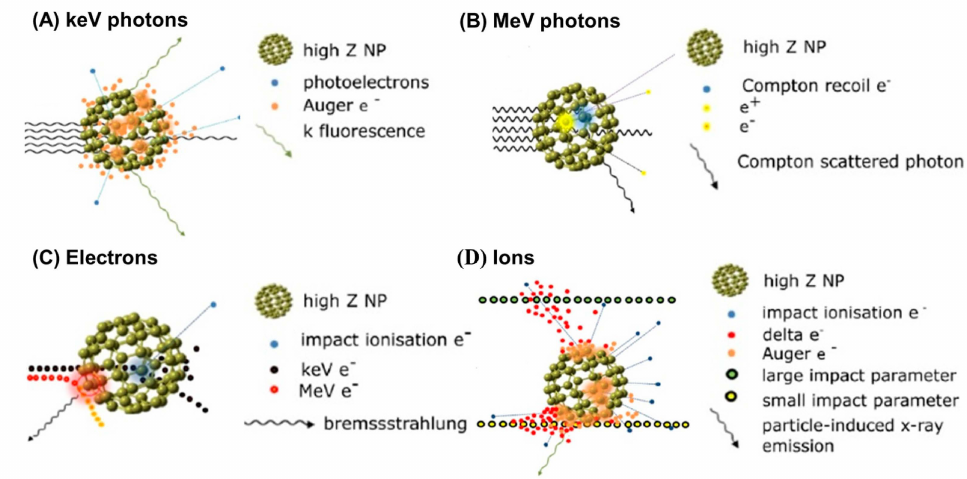
Figure 3. Schematic illustration of inelastic interactions with a high − Z NP for: ( A ) incident keV pho- tons (orange clouds represent photoelectric events); ( B ) incident MeV photons (blue and yellow clouds represent Compton scatter and pair production events, respectively); ( C ) incident electrons (blue and red clouds represent large and small impact parameters leading to ionization and bremsstrahlung, respectively); and ( D ) incident ions (orange clouds indicate impact ionization events). Adapted with permission [61]. IOPSCIENCE, Copyright